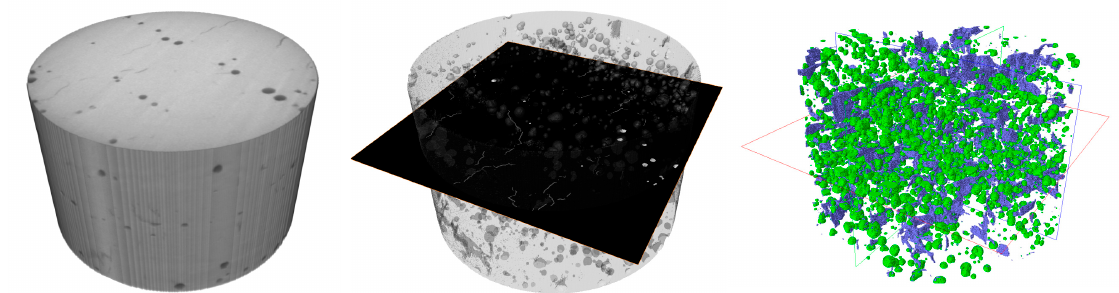
Figure 15. Three-dimensional reconstruction of the tomography dataset in Avizo; ( left ): original dataset, ( middle ): segmented dataset using AI with cross section, ( right ): quantified distribution of cracks and pores (blue: cracks, green: pores).